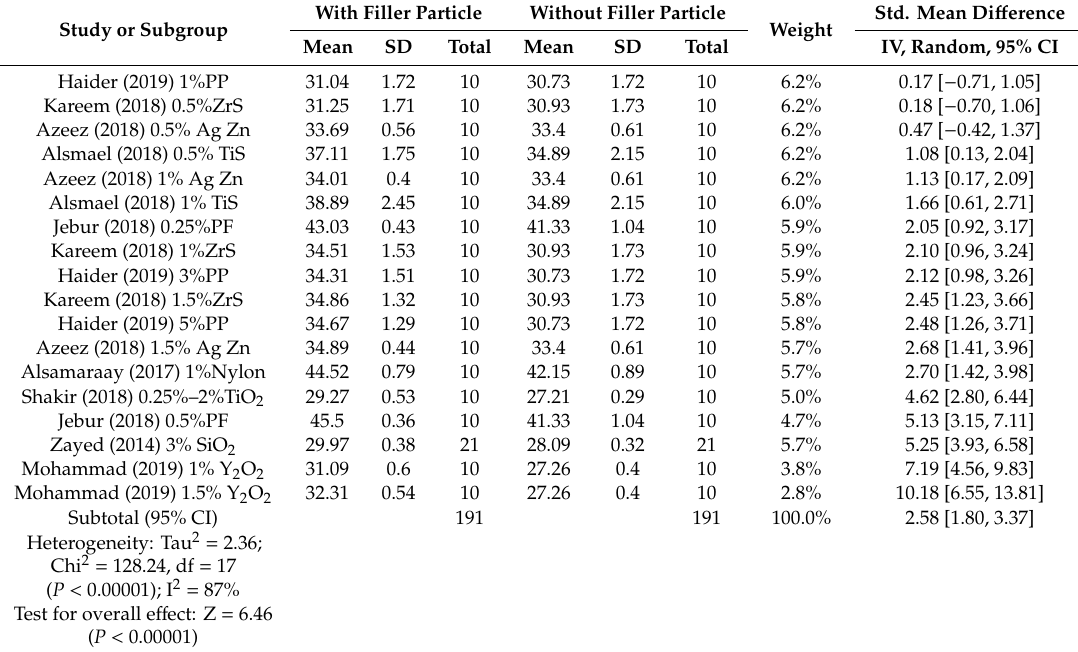
Table 7. Summary findings and forest plot of hardness (Shore A) outcomes in case-control studies incorporating filler particles with